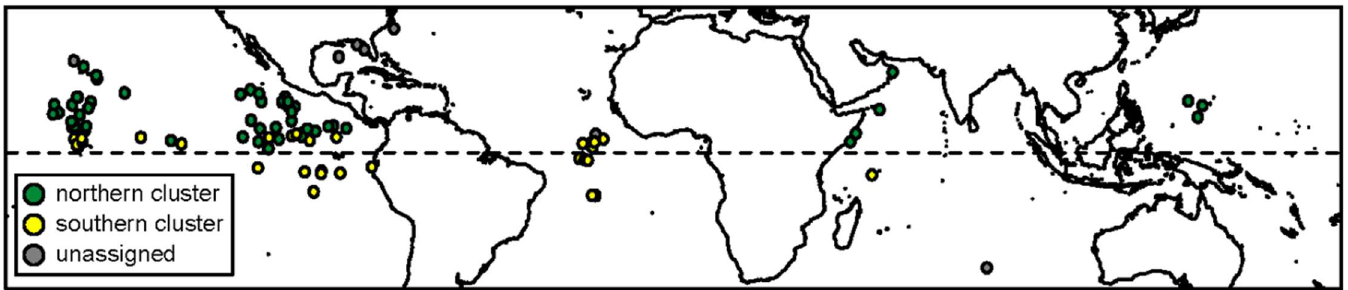
Fig 3. Map of Exocoetus volitans population assignments. After cluster analysisusing Genelandv.1 [17], posterior probabilities of assignment were loadedinto ArcGIS, version 9.3.1 (ESRI, Redlands,CA, USA). Green circles = individualsassignedto the "Northern cluster", Yellow circles = individuals assignedto "Southern cluster", and Grey circles = individuals with low confidencein cluster assignment (posterior probability values <